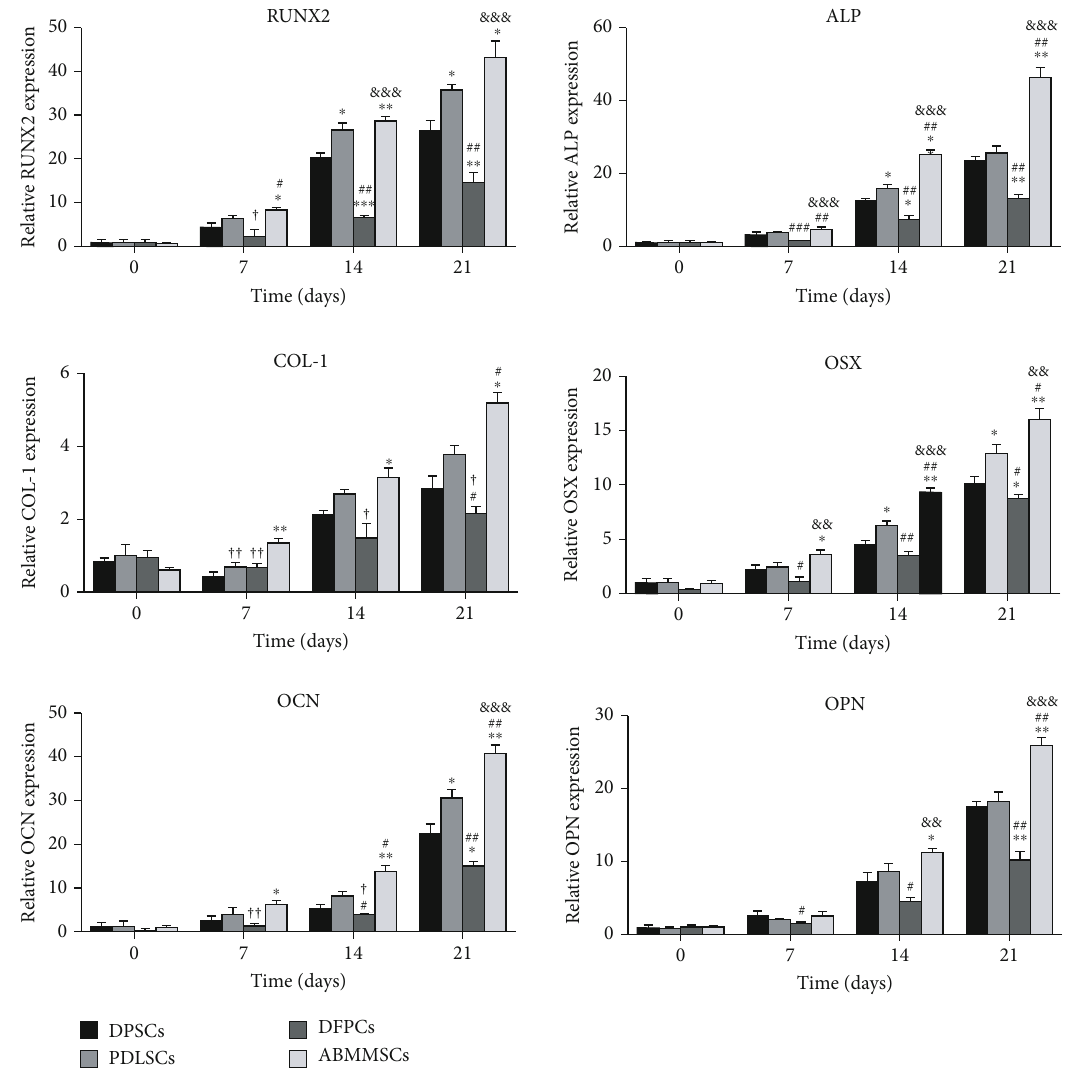
Figure 4: Gene expression for osteogenic di ff erentiation. qRT-PCR was performed to analyze the potency of osteogenic di ff erentiation in DPSCs, PDLSCs, DFPCs, and ABMMSCs at days 0, 7, 14, and 21. The y -axis represents the relative mRNA fold change, which was calculated using the 2 − ΔΔ Ct formula with β -actin as the internal control. Error bars represent the SD ( n = 3 ) ( ∗ p < 0 : 05 , ∗∗ p < 0 : 01 , and ∗∗∗ p < 0 : 001 vs. DPSCs; # p < 0 : 05 , ## p < 0 : 01 , and ### p < 0 : 001 vs. PDLSCs; & p < 0 : 05 , && p < 0 : 01 , and &&& p < 0 : 001 vs. DFPCs; † p < 0 : 05 , †† p < 0 : 01 , and ††† p < 0 : 001 vs.